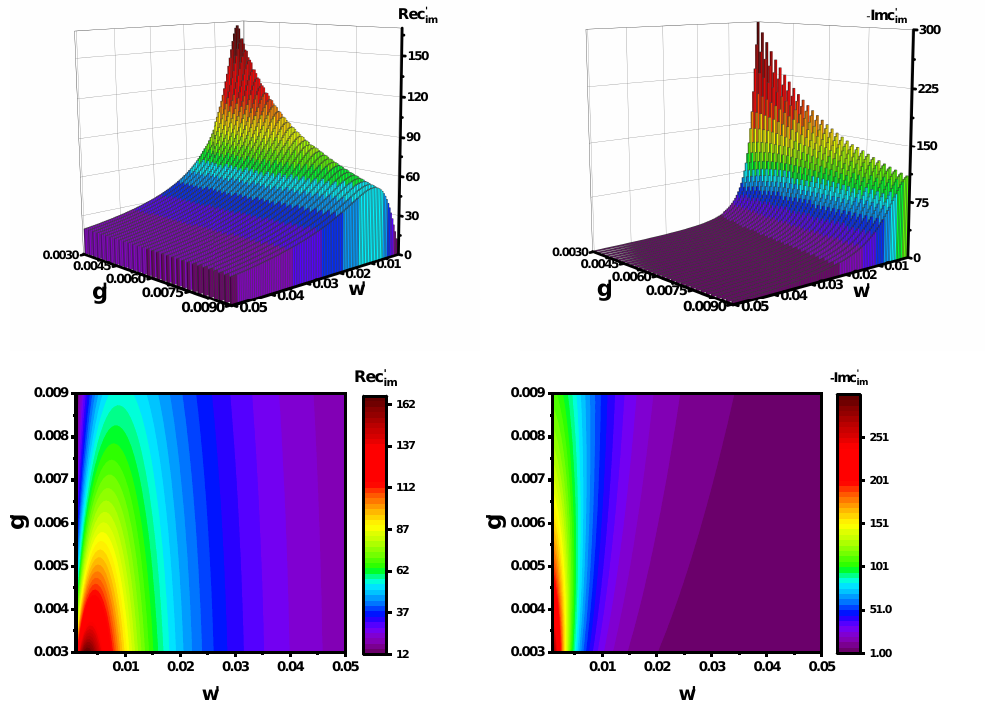
Figure 2. 3D bar and contour plot of the real and imaginary parts of polarization function in the (cid:48) 0, TB presence of impurity, χ imp